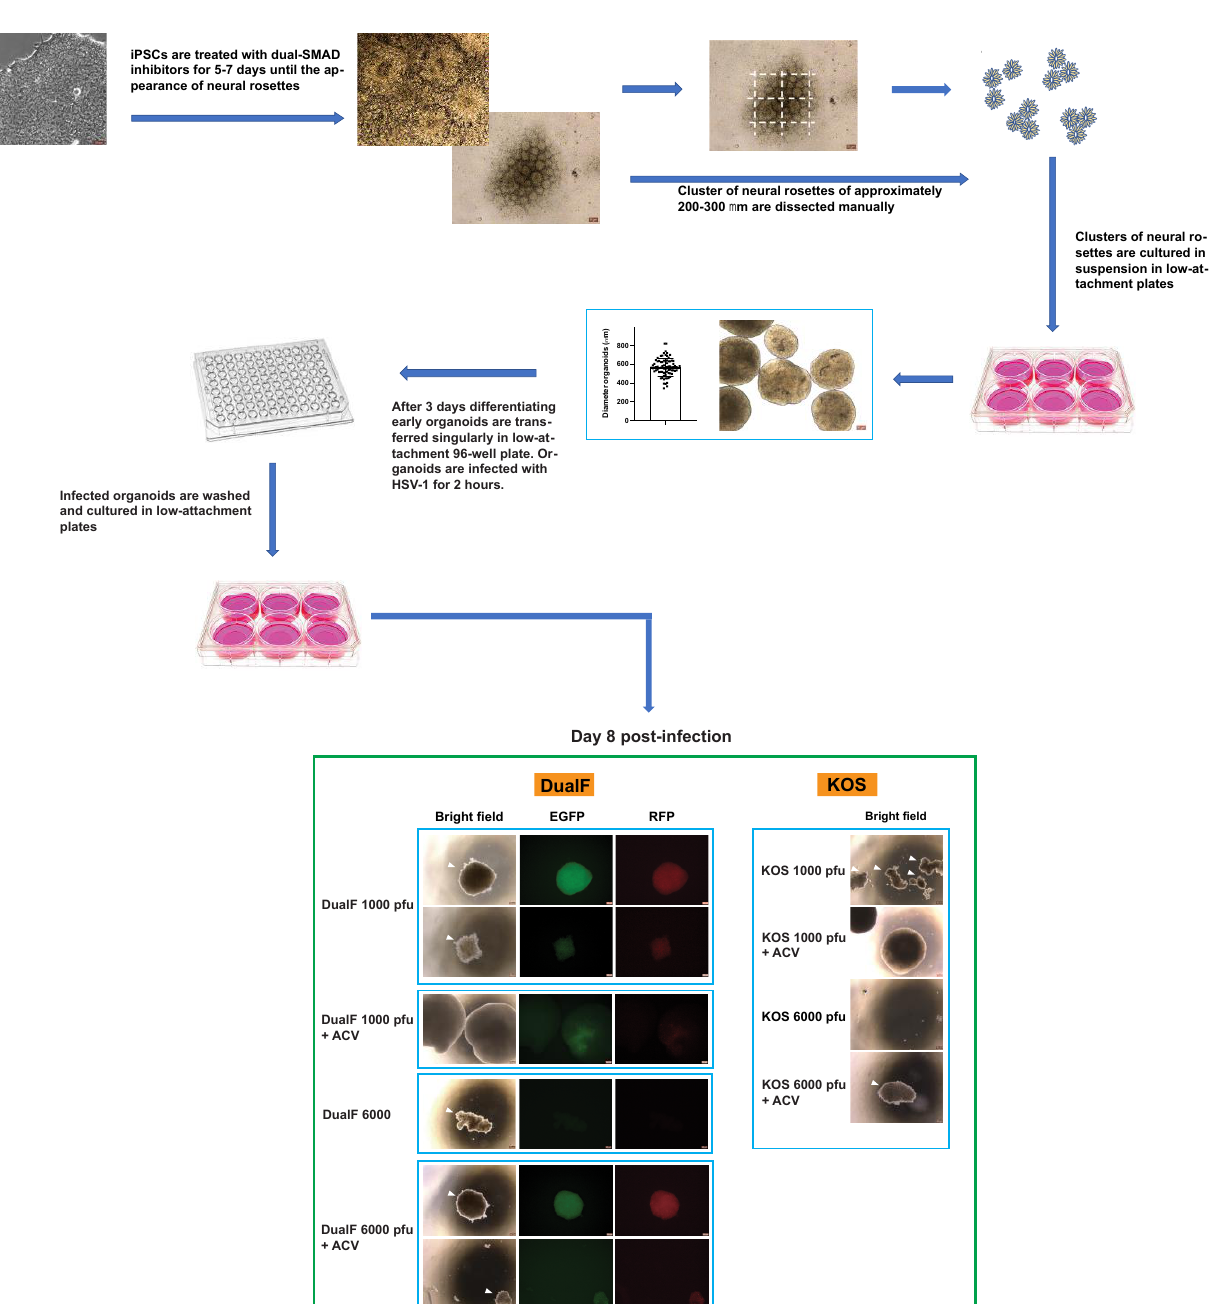
Figure 1. Generation and infection of early-stage brain organoids derived from manually isolated neural rosettes. Neural rosettes were generated by the treatment of iPSCs with dual-SMAD inhibitors. Clusters of neural rosettes were isolated manually and transferred into low attachment plates to allow for their circularization and expansion. Neural rosettes were infected individually with 1000 and 6000 pfu of HSV-1 DualFP (a KOS-based recombinant virus in which enhanced green fluorescent protein (EGFP) and monomeric red fluorescent protein (RFP) are reporters whose expression is driven by the viral promoters ICP0 and glycoprotein C, respectively) and HSV-1 strain KOS in the presence or absence of ACV. Organoids infected at higher PFU exhibited a greater degree of degradation, indicating a dose effect, and infected organoids cultured with ACV exhibited no apparent degradation at 1000 pfu but not at 6000 pfu. Together, these observations indicate a causal link between HSV-1 infection and loss of organoid structural integrity. Examples of organoids whose structural integrity was affected by HSV-1 infection are indicated by